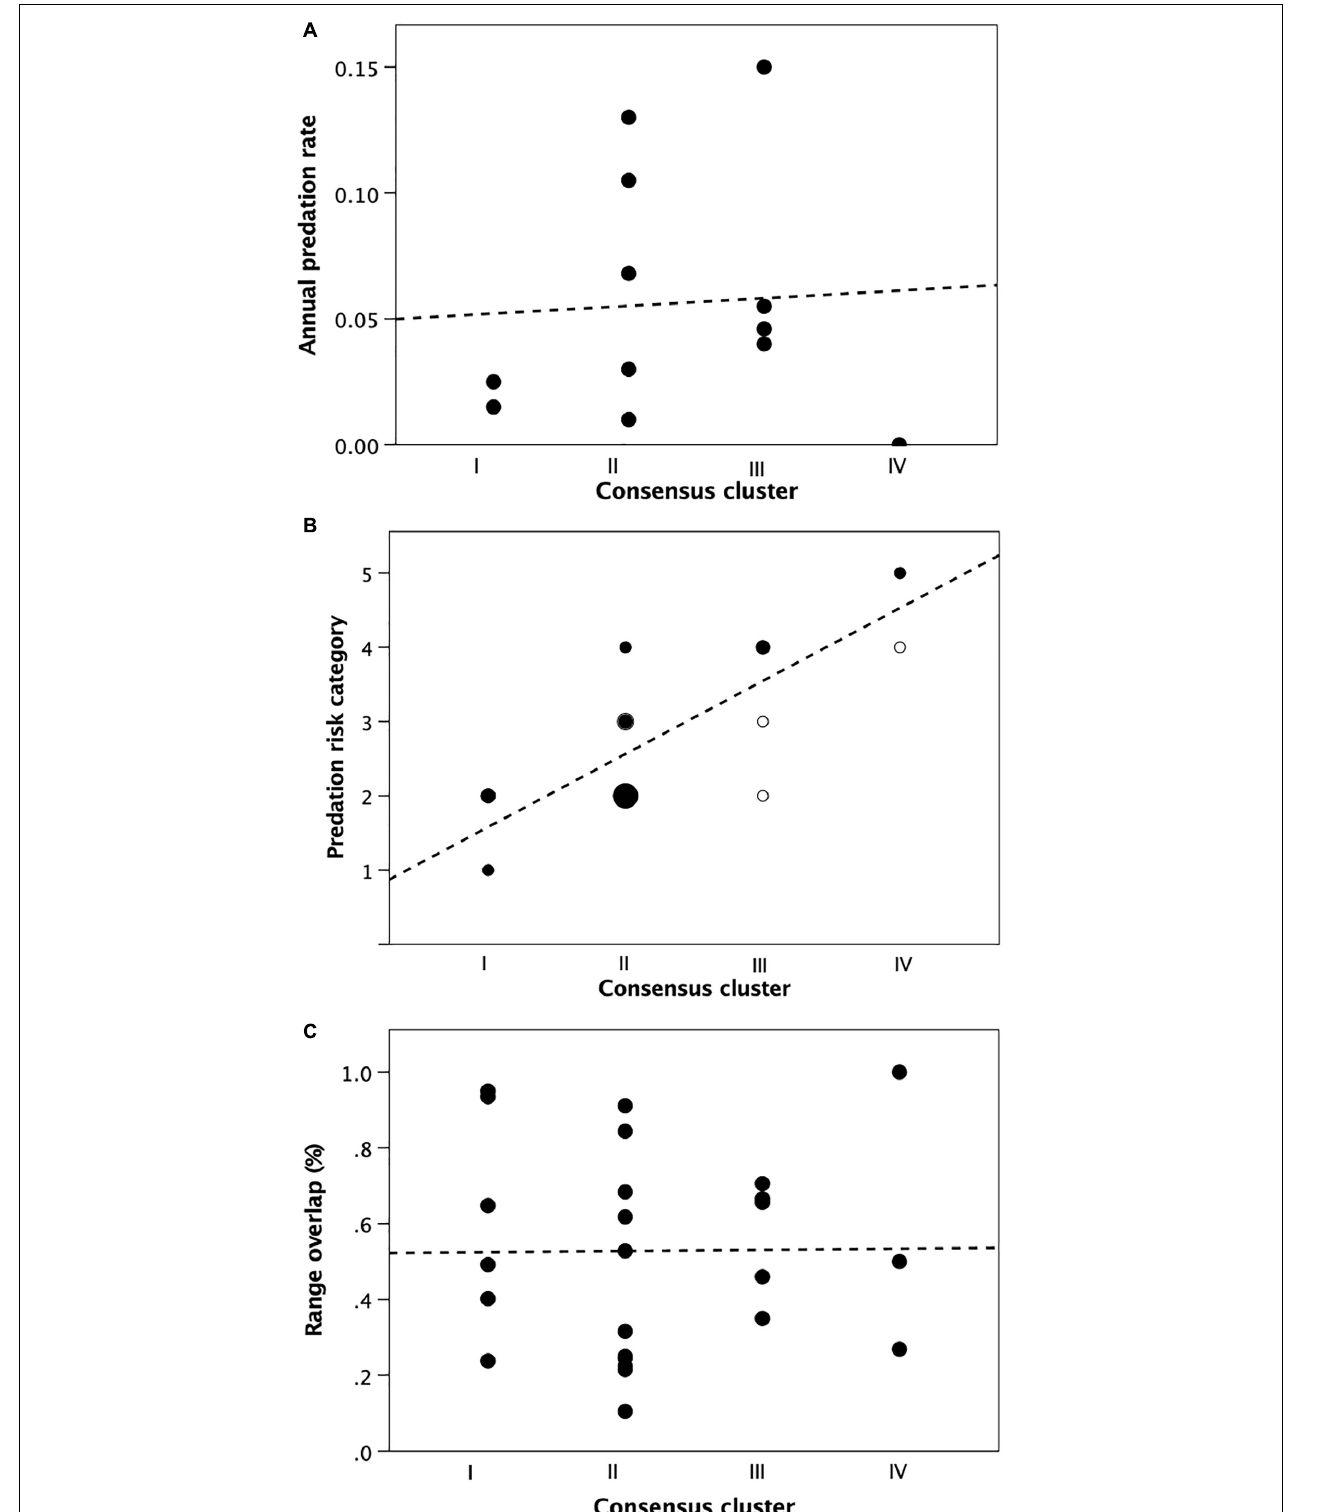
FIGURE 9 | External threats experienced by primate genera as a function of cluster membership from Table 1 : (A) Observed predation rate; (B) Predation risk of habitats typically occupied by genus: 1 (low risk) = small-bodied, arboreal forest; 2 = large-bodied, arboreal forest; 3 = terrestrial forest; 4 = terrestrial woodland; 5 (high risk) = open country; small unfilled symbol: 1 datapoint; small filled symbol: 2 datapoints; medium filled symbol: 3 datapoints; large symbol: 7 datapoints; (C) mean proportion of overlap with the ranges of neighbouring conspecific groups (as an index of risk of conflicts). Source: Supplementary Dataset 5 .